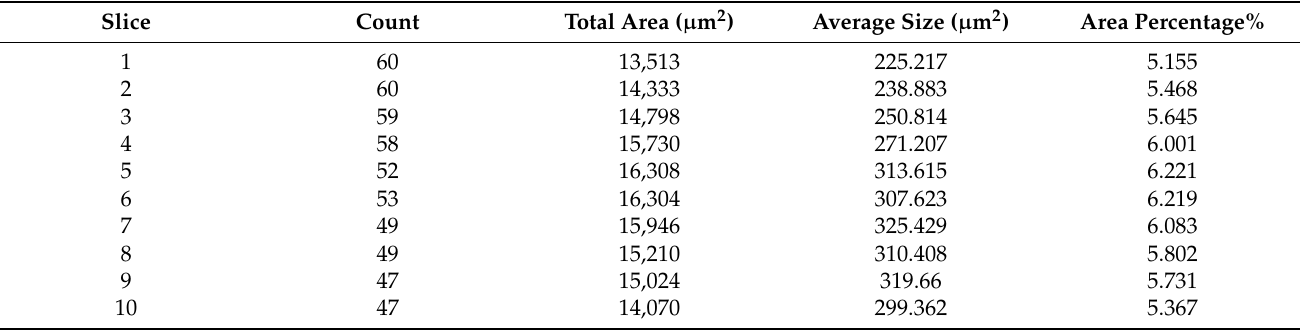
Table 3. Size analysis of segment 0 (pore) in the segmented